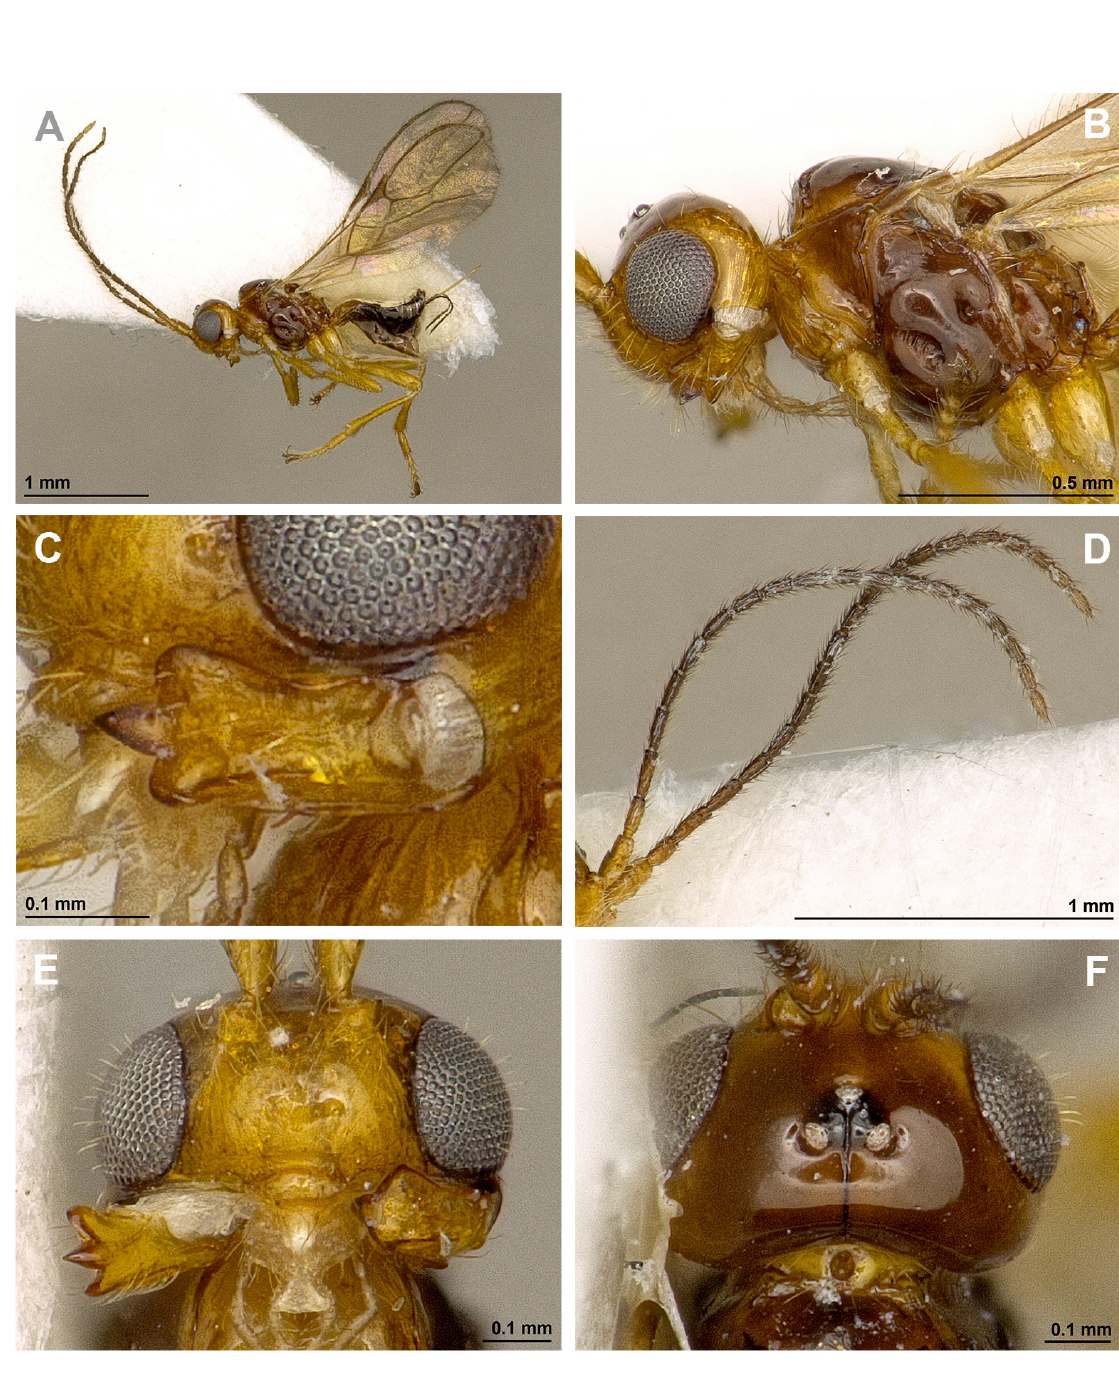
Fig. 76. Asobara zaprionae van Achterberg, sp. nov., ♀, holotype (RMNH). A . Habitus, lateral view. B . Head and mesosoma, lateral view. C . Mandible. D . Antenna. E . Head, front view. F . Head, dorsal